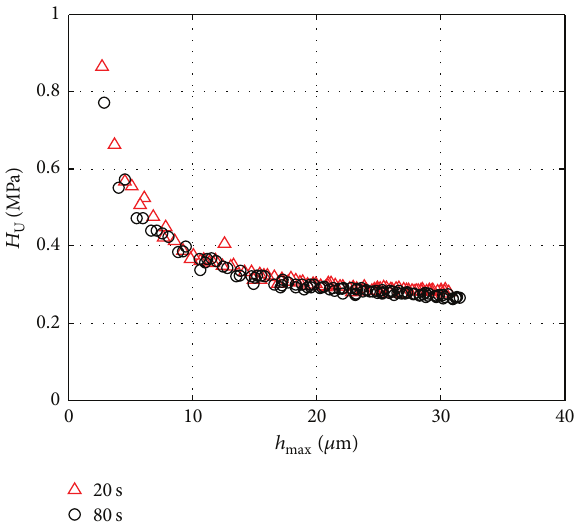
Figure 26: Universal hardness of PDMS determined by a Berkovich tip with different loading times of 20 and 80 s